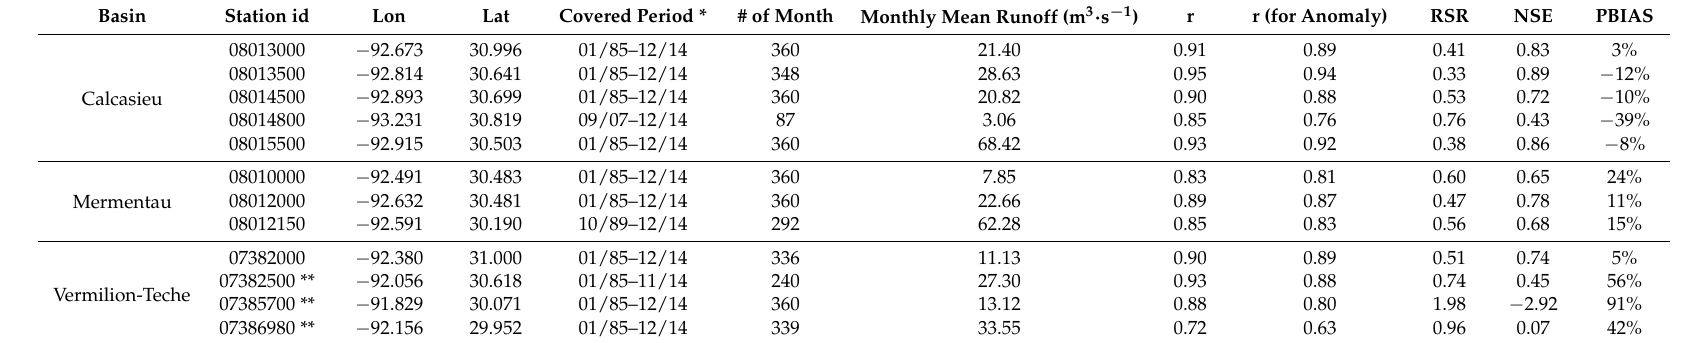
Table 3. Information of USGS gauge stations and model-data